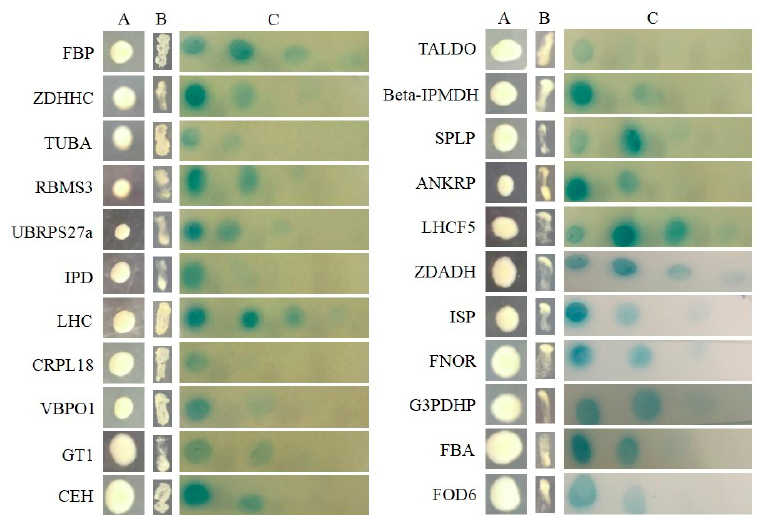
Figure 2. Plasmid linkage assays for DK transformants identified during yeast two-hybrid screening. Transformants containing the bait and prey plasmids were identified based on their growth on dropout medium (SD -Leu-Trp ; column A). Putative interacting partners were identified based on their growth on SD -Leu-Trp-His-Ade (column B), and the interaction strength was detected on SD -Leu-Trp-His-Ade medium with α -x-gal (column C), each drop concentration ranged from 10 − 1 , 10 − 2 , 10 − 3 to 10 − 4 .